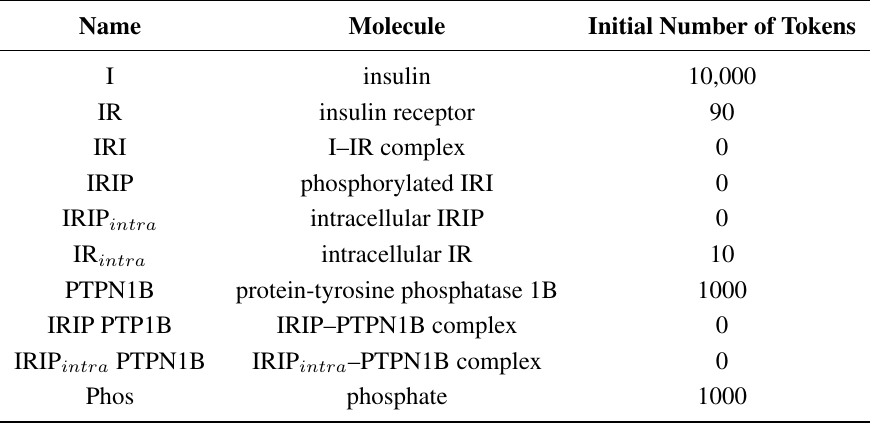
Table 3. List of places of the TPN and the initial numbers of tokens.